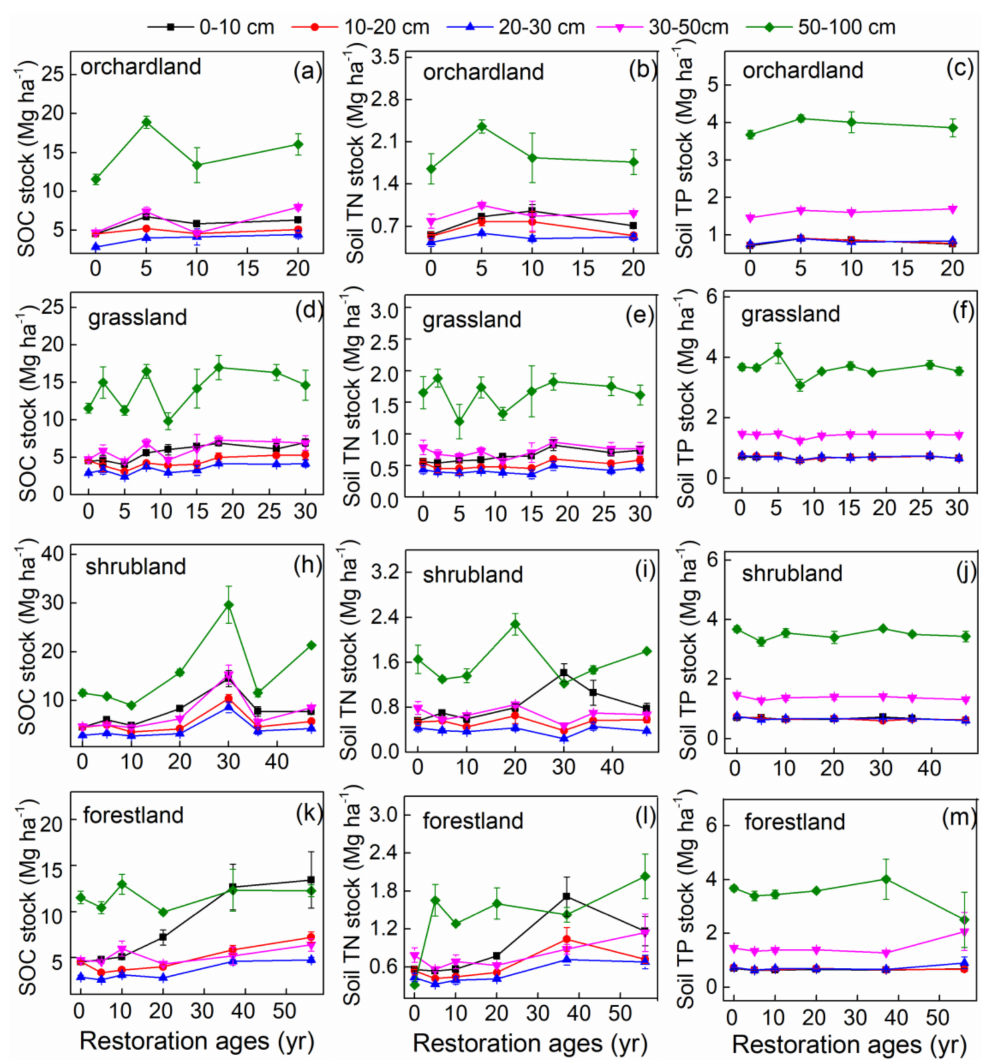
Figure 2. Changes in stocks of soil organic carbon (SOC), soil total nitrogen (TN), and soil total phosphorus (TP) with restoration age. Note: values are mean ± standard